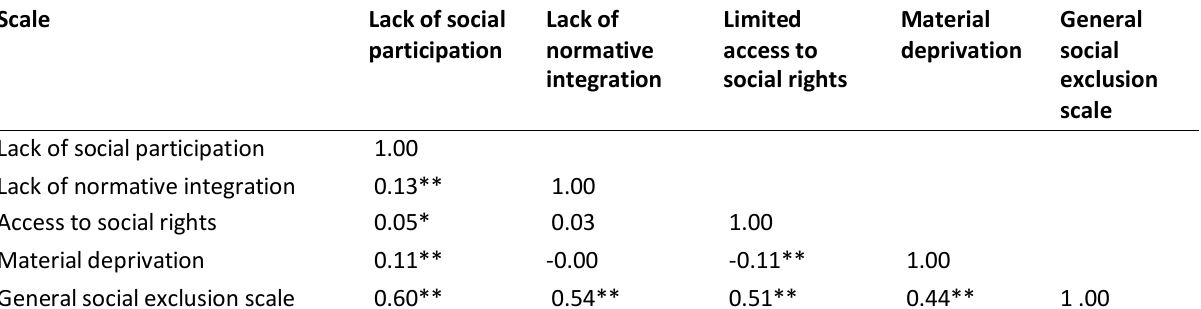
Figure 1. Distribution on the general social exclusion scale for Dutch children aged 8-17 years (CatPCA object scores, weighted sample). Source: ASOUK’08 dataset. Table 2. Relationships between sub-dimensions and the general social exclusion index for Dutch children (Pearson cor- relations, weighted